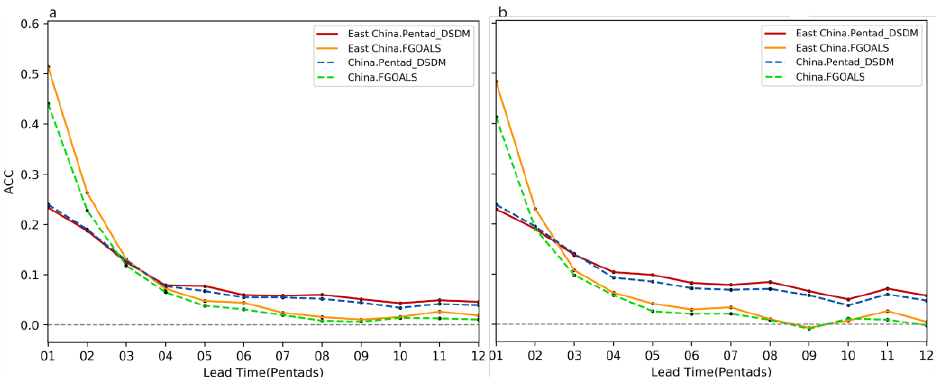
Figure 5. ACCs of the precipitation anomalies forecast from 2000 to 2018 for the pentad DSDM and FGOALS-f2 model. ( a ) The annual average (from the first pentad in January to the sixth pentad in December) and ( b ) the summer average (from the first pentad in June to the sixth pentad in August).